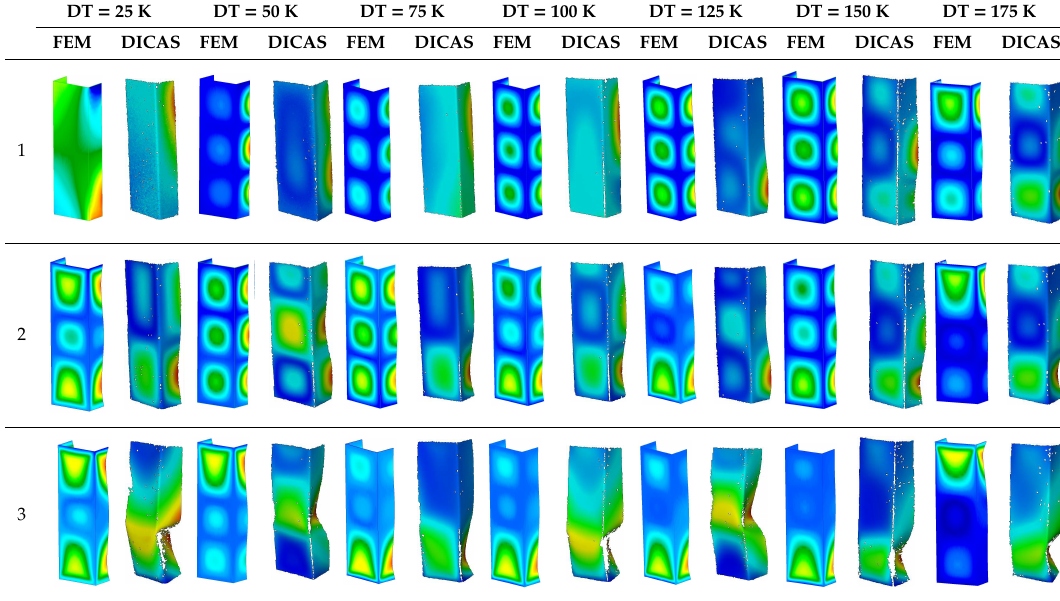
Table 4. The comparison of recorded modes in total displacements for both methods.